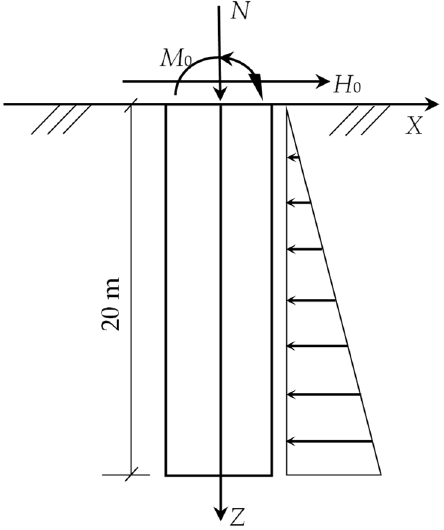
Figure 7. Schematic diagram of a single pile and loadings.